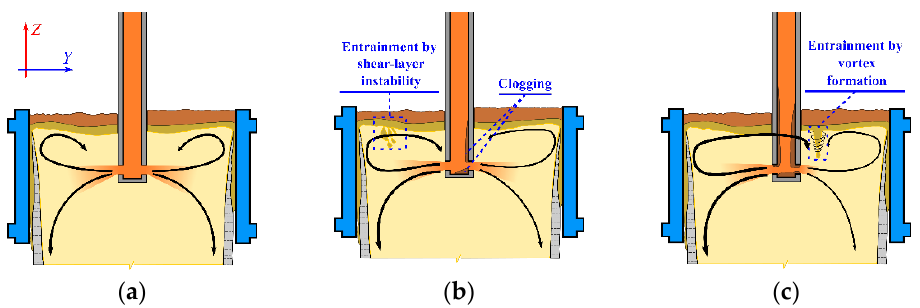
Figure 1. Schematic description of the hydrodynamic behavior inside the mold. ( a ) Double-roll symmetric behavior. ( b ) Low asymmetric behavior with slag entrainment by shear-layer instability. ( c ) Severe asymmetric behavior with slag entrainment by vortex formation.